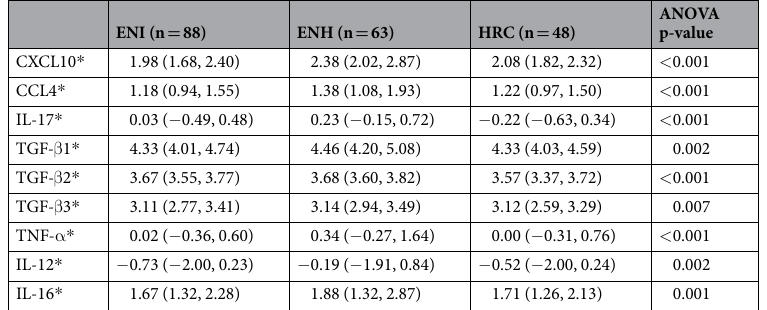
Table 3. Significant differences of SIM concentrations in HBeAg negative phases of chronic HBV; Kruskal- Wallis ANOVA. * log 10 pg/mL (median, 10–90%